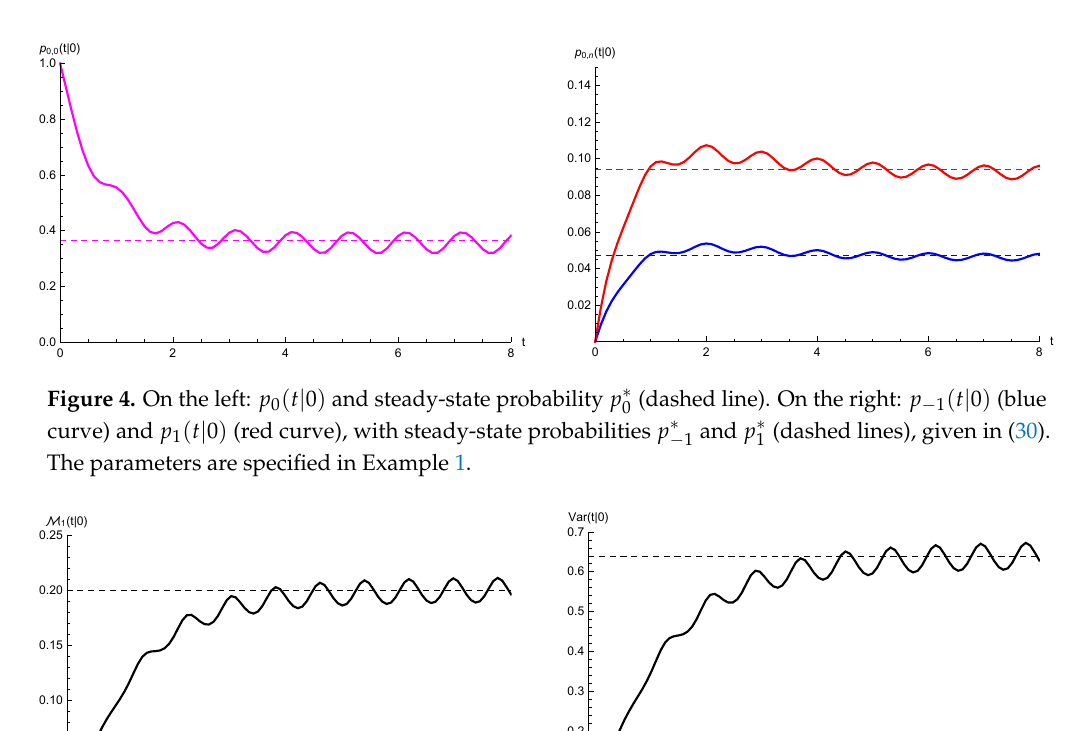
Figure 5. Plots of the mean M 1 ( t | 0 ) (left) and the variance of Var ( t | 0 ) (right) of the process N ( t ) , obtained by means of (24). The dashed lines indicate the asymptotic values M ∗ are specified in Example